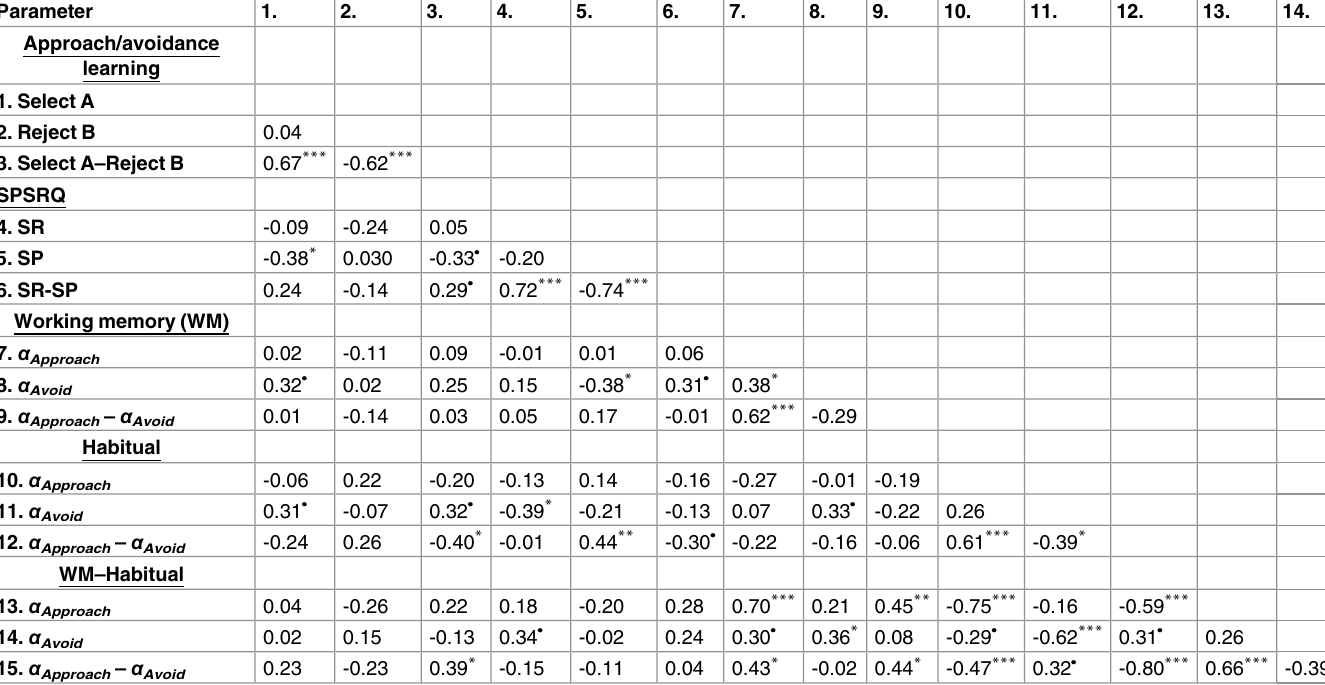
Table 4. Correlations between approach/avoidance learning, SPSRQ scores, and learning rates. Mean ± SEM. Parameter